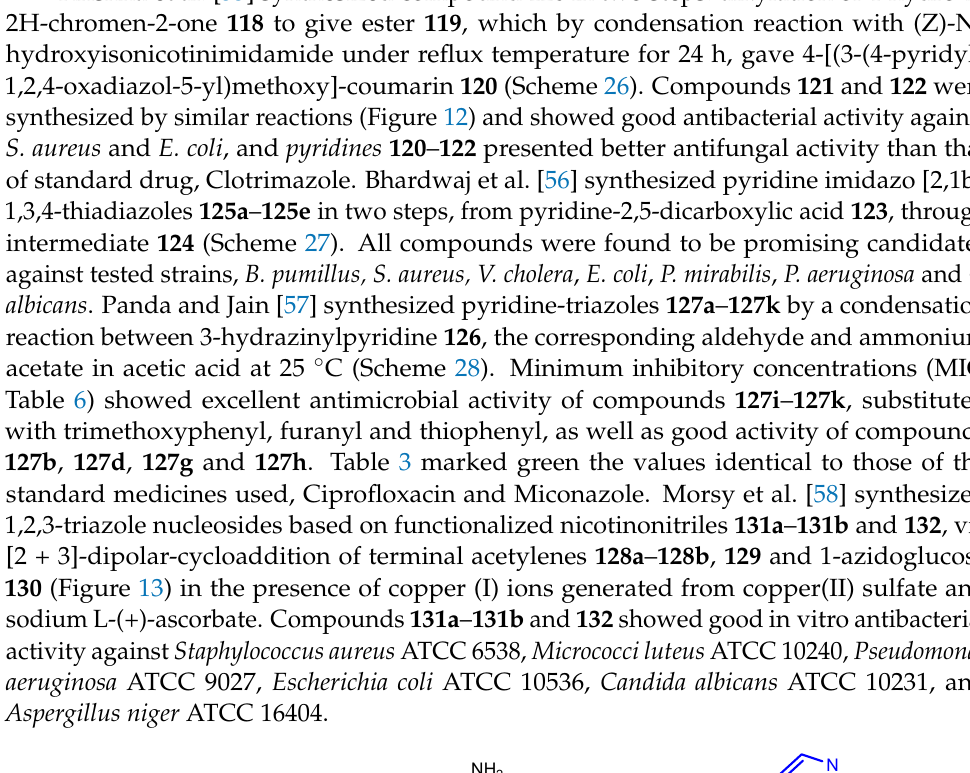
16 of 41 Figure 11. Pyridyl-pyrazole-1,3,4-oxadiazoles 115a − 115d [53]. 5. Synthesis of Antimicrobial Pyridine Compounds Containing a Five-Membered Ring with Three Heteroatoms Murty et al. [54] synthesized 1,3,4-oxadiazoles–pyridines 117a – 117c through an oxi- dative C–O coupling by direct C–H bond activation of N-aroyl-N-arylidinehydrazines 116a – 116c using a catalytic quantity of CuO nanoparticles (Scheme 25). Compound 117a showed broad-spectrum antibacterial activity for all tested strains, E. coli , B. subtilis, M. luteus, K . pnemoniae MIC 37.5 µg mL − 1 , and compounds 117a and 117b exerted antifungal activity better than standard drug, Cycloheximide. O